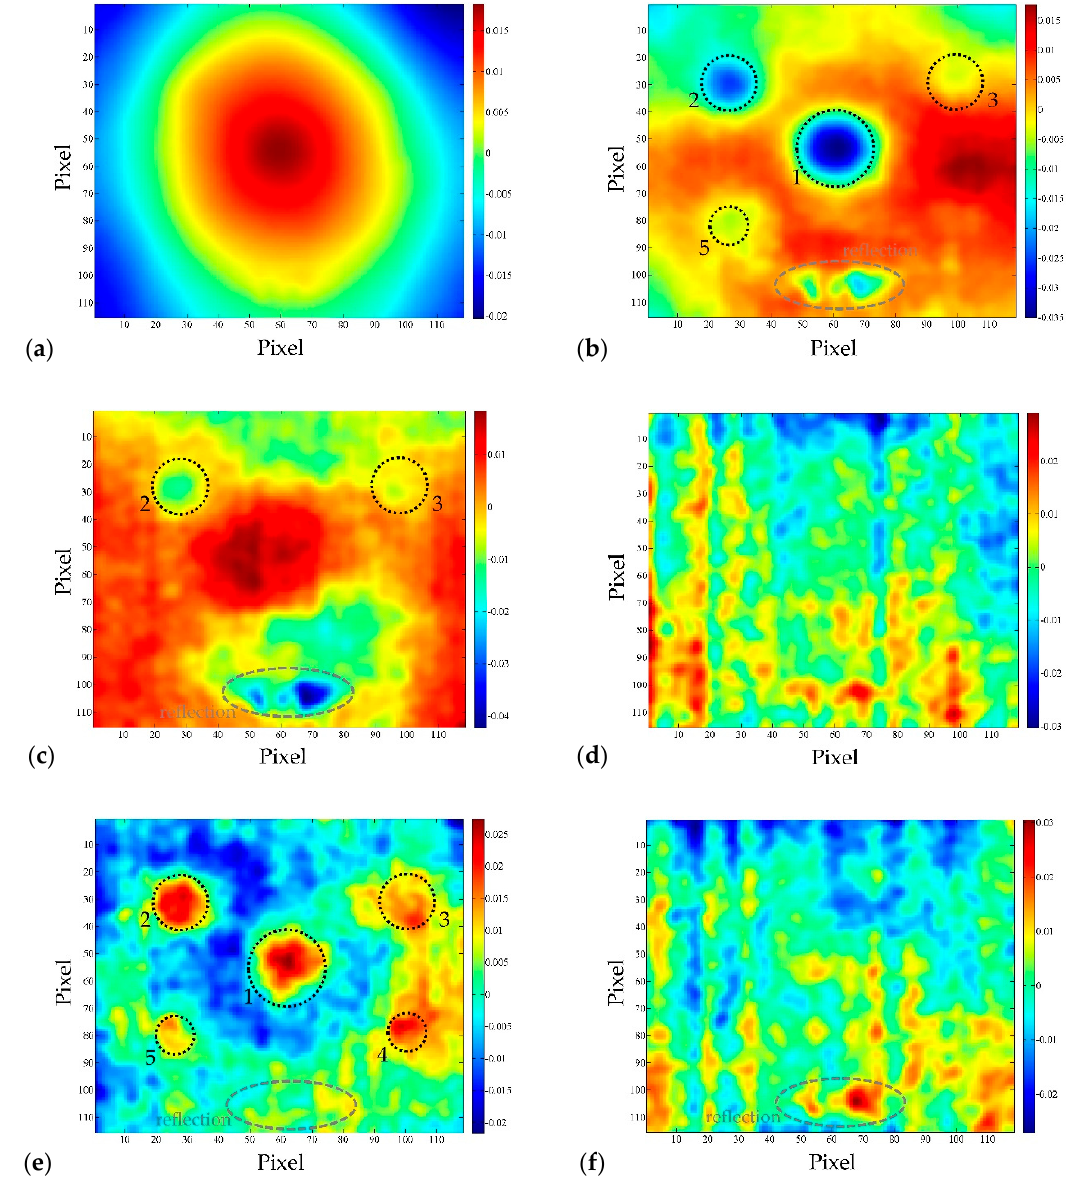
Figure 7. BM 1–1 bottom side, distance 1.5 m: ( a ) EOF 1 ; ( b ) EOF 2 ; ( c ) EOF 3 ; ( d ) EOF 4 ; ( e ) EOF 5 ; ( f ) EOF 6. ( f ) EOF 6 Table 3. SNR values obtained from EOFs presented in Figure 7.